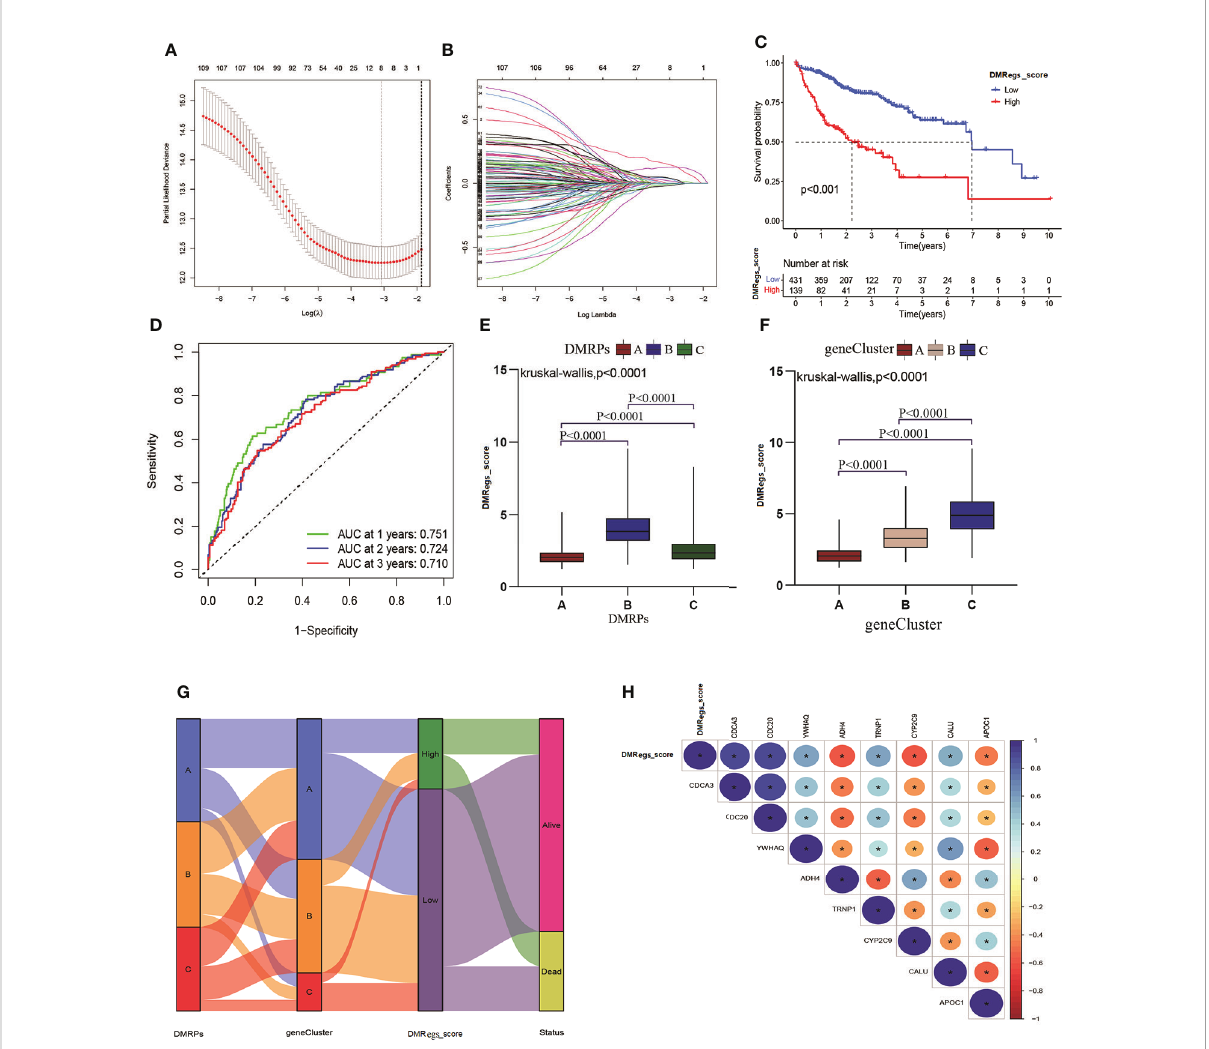
FIGURE 6 Generation of DMRegs_score. (A, B) The screen of candidate prognostic genes through LASSO cox regression analysis. (C) Survival analysis of the OS between different risk groups. (D) The predictive value of DMRs score. (E, F) The differences of DMRegs_score among DMRPs and gene clusters, respectively. (G) Sankey diagram of the DNA patterns, gene clusters, DMRegs_score and survival status. (H) The correlation between DMRegs and DMRegs_score. * P < 0.05, ** P < 0.01, *** P < 0.001, **** P <